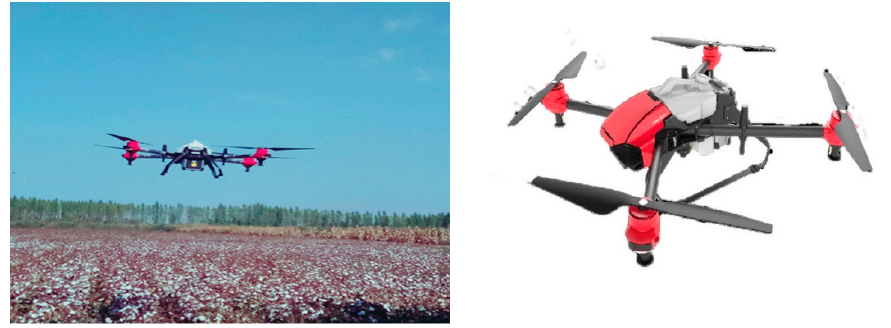
Figure 1. Unmanned aerial vehicle (UAV) sprayer (P30 UAV).